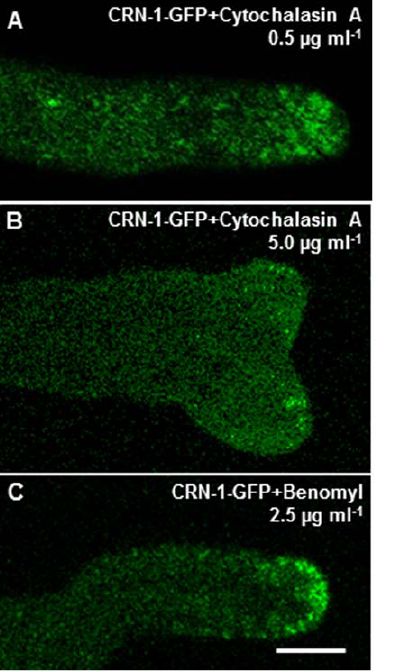
Figure 3. Effect of cytoskeleton depolymerization drugs on the localization and integrity of coronin patches. Hyphae exposed to: (A) the anti-actin drug, 1.0 m g ml 2 1 cytochalasin A, (B) 5.0 m g ml 2 1 cytochalasin A, and (C) the anti-tubulin drug 2.5 m g ml 2 1 benomyl.